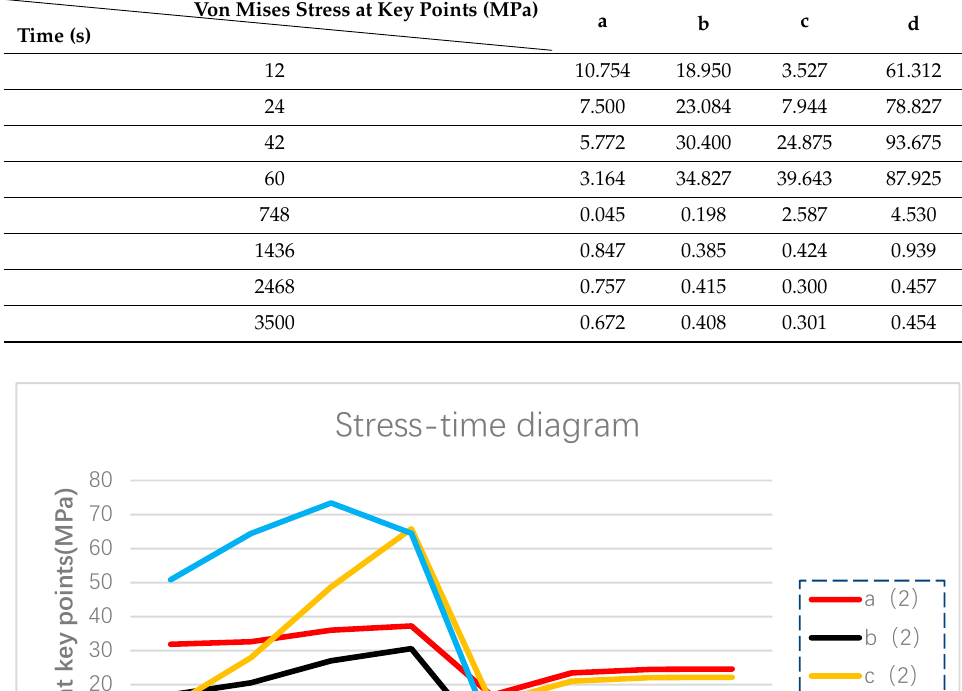
Table 2. Stresses at the four critical points of the pressure plate under the first type of constraint.